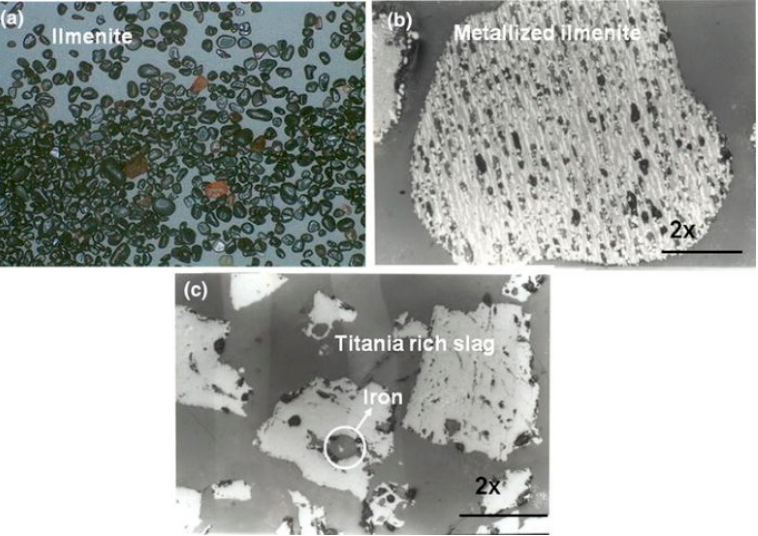
Figure 13. Optical microscope images of: ( a ) ilmenite; ( b ) metalized ilmenite; ( c ) Ti-rich slag with iron metal. Reprinted from [51] with permission from Springer 2016.